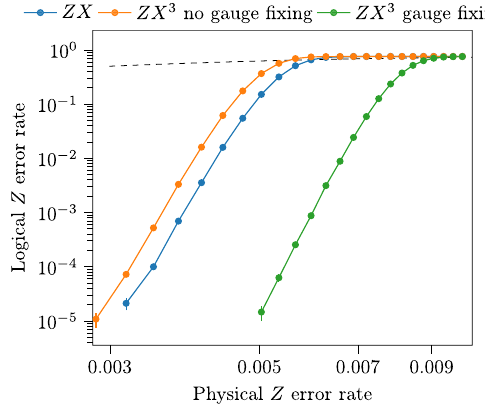
¯ Z FIG. 16. Logical error rate of the ½½ 2028 ; 2 ; 26 (cid:2)(cid:2) subsystem toric code using a ð ZX Þ 36 schedule, as well as a ð ZX 3 Þ 12 schedule (using only a single ancilla by introducing idle time steps) with and without using gauge fixing in the matching graph. All schedules use 144 time steps, and the independent circuit-level noise model is used. The dashed black line is the probability that either of two physical qubits will suffer a Z error during 144 time steps without using error For each of the schedules for which p th is plotted in total Fig. 15, there are two regimes: to the left and to the right of the peak. To the left of the peak, the threshold is limited by the X threshold, and is therefore given by Eq. (8), which is linear in η . To the right of the peak, the threshold is limited by the Z threshold, and is therefore given by Eq. (7), which is linear in 1 = η . The optimal η for a given schedule can be found by setting p Z th . ¼ p X th total total